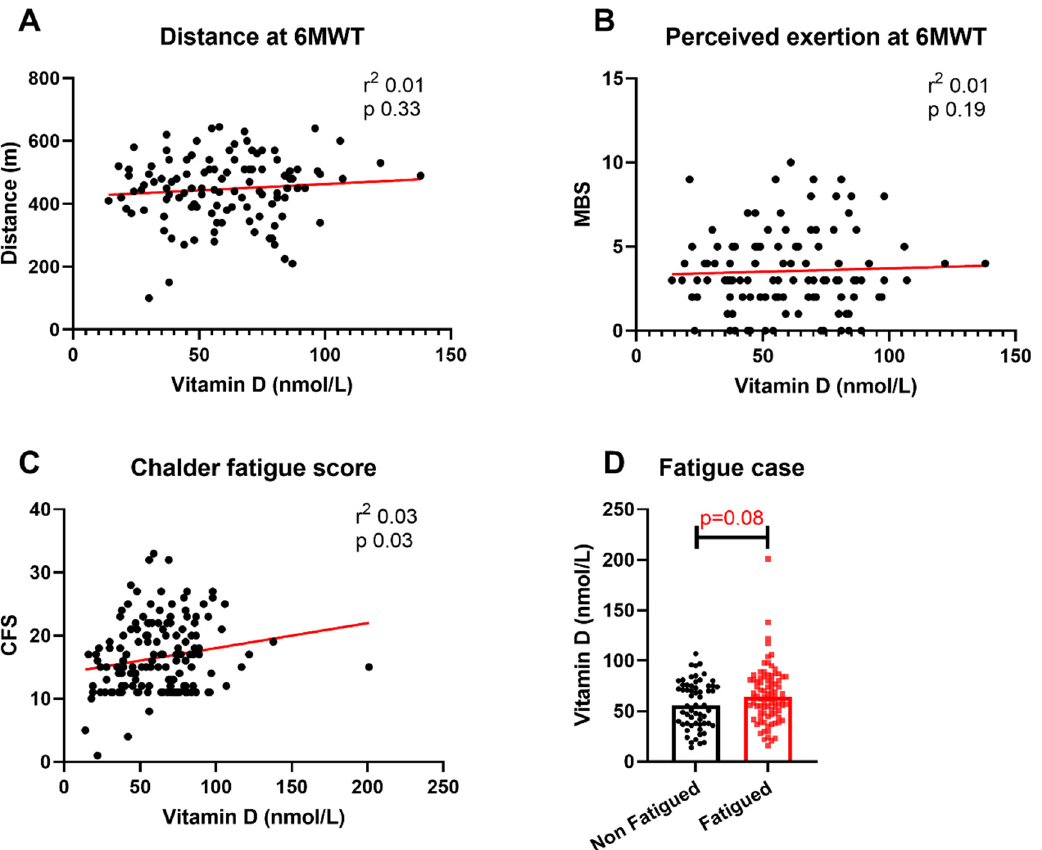
Figure 1. Relationship between vitamin D levels and physical outcomes. Relationship between vitamin D levels and ( A ) distance covered at 6MWT, ( B ) maximal MBS score during 6MWT, ( C ) total CFS score and ( D ) fatigue case status. 6MWT = six-minute walk test; MBS = modified Borg scale; CFS = Chalder Fatigue Score. Differences assessed using unadjusted linear regression and Wilcoxon rank-sum test. Table 2. Multivariable regression analysis of relationship between vitamin D levels and physical health